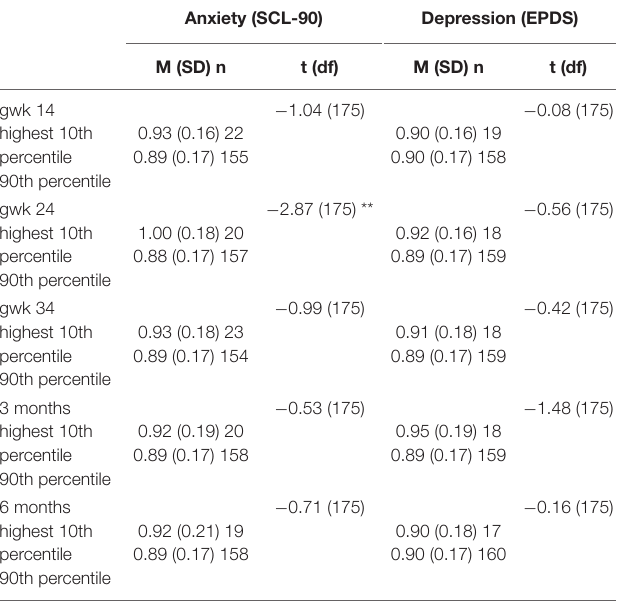
TABLE 4 | Differences in the unpredictability of maternal sensory signals between elevated (highest 10th percentile) and lower level (90th percentile) of anxiety and depressive symptom groups ( n = 177).